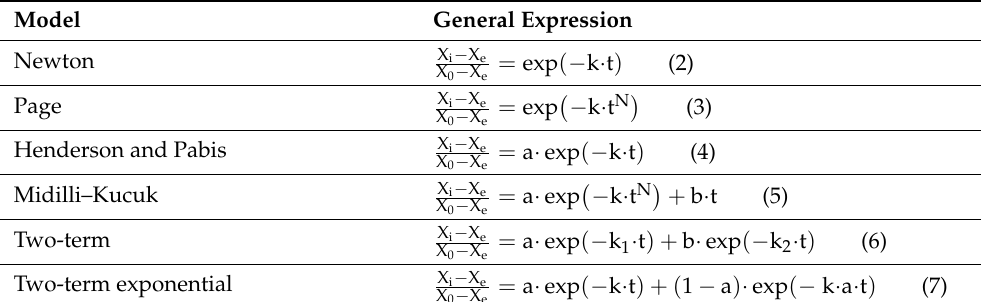
Table 2. Thin-layer drying models fitted to drying curves.